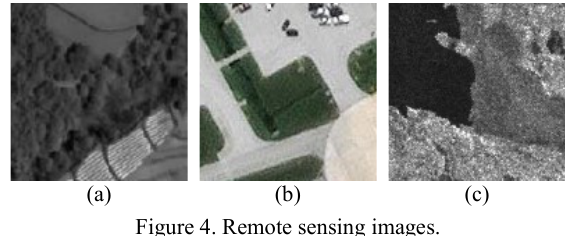
Figure 4. Remote sensing images. Figure 5(a1)-(c1) are the segmentation results of remote sensing